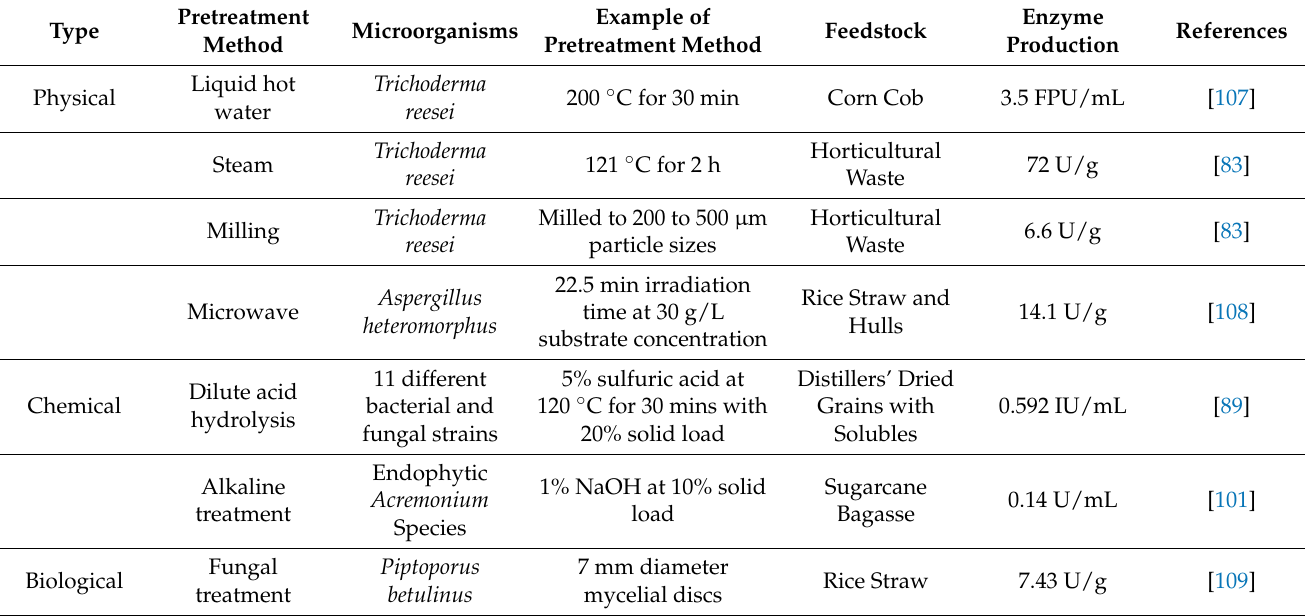
Table 3. Pretreatment types and examples for the production of lignocellulolytic enzymes